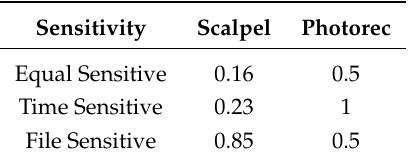
Table 1. Initial reward values of Scalpel and Photorec for all three